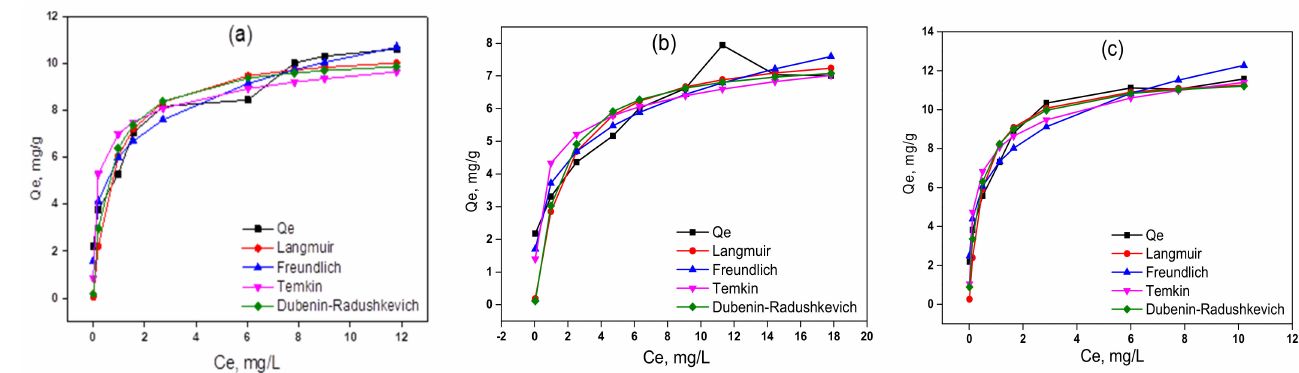
Figure 11. Adsorption isotherms of IC on ( a ) RPS, ( b ) PST1, and ( c )